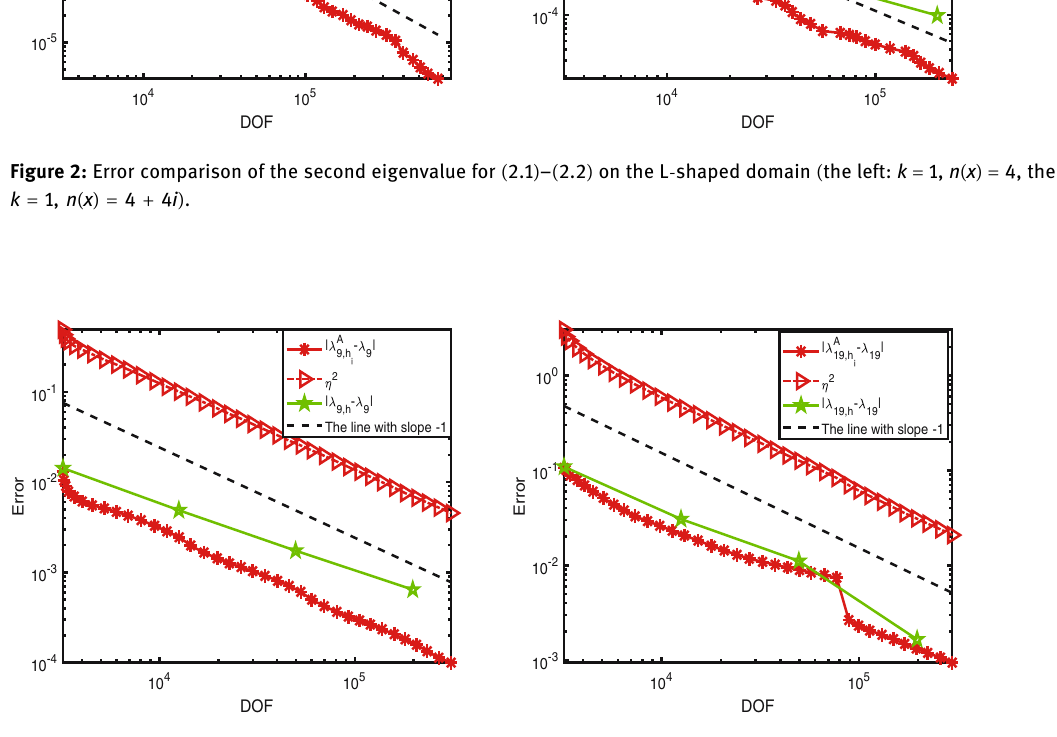
Figure 3: Error comparison of the eigenvalues for ( 2.1 ) – ( 2.2 ) on the L - shaped domain ( the left: k = 2, n ( x ) = 4 + 2 i , the right: k = 4, n ( x ) = 4 + i )